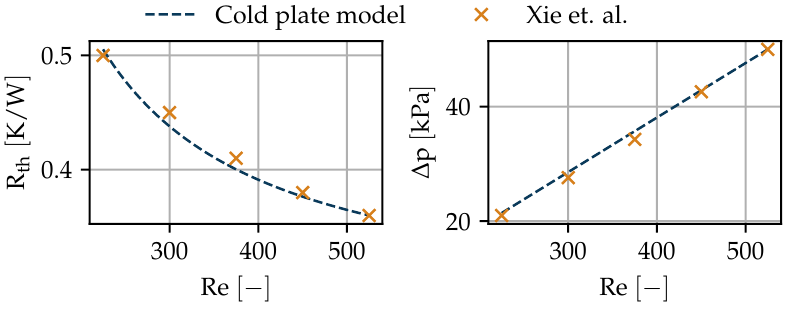
Figure 2. Coldplate model validation for thermal resistance ( left ) and pressure loss ( right ) with data from